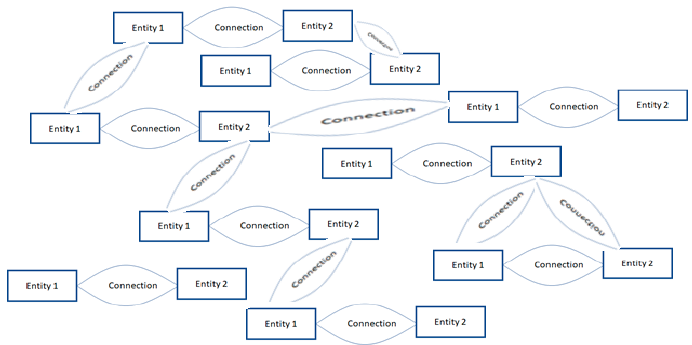
Figure 4. A network of knowledge structures showing the state